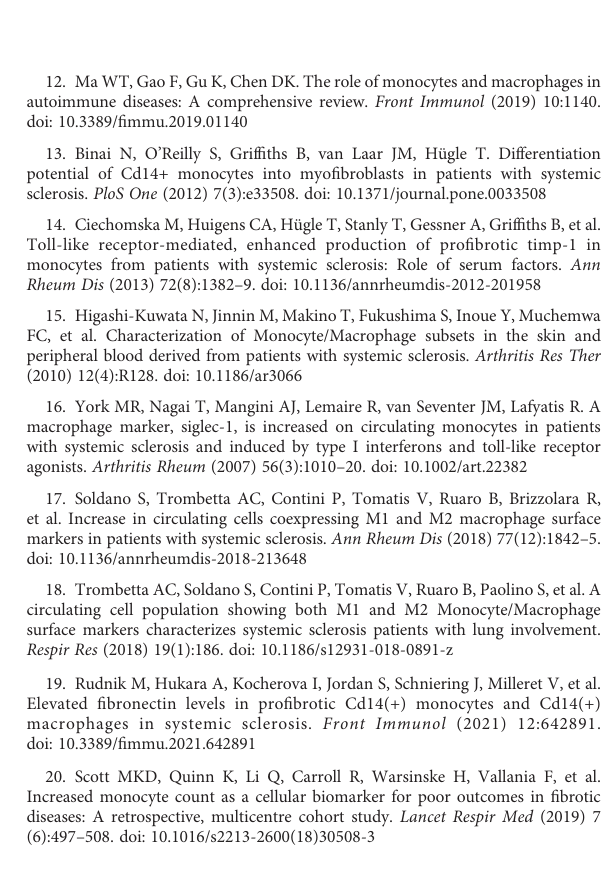
SUPPLEMENTARY FIGURE 1 Expression of M1 and M2 marker on CEACAM-positive monocytes. The expression of CD86, HLA-DR, and CD163 on CEACAM-positive and CEACAM-negative monocytes was analyzed using CyTOF (n=5). The Mean Metal Intensity (MMI) of each molecule in CEACAM-positive and CEACAM-negative monocytesisindicated. P valueswerecalculatedusing paired t-tests. ** P <